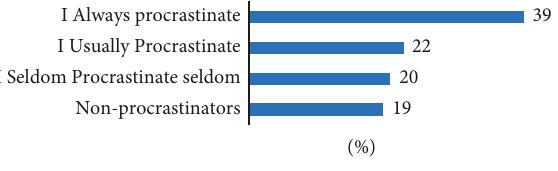
Figure 1: Levels of academic